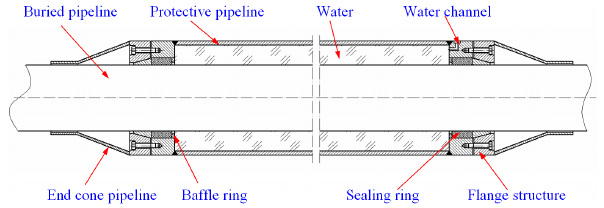
Figure 15. A protective device of the buried pipeline crossing re- verse fault